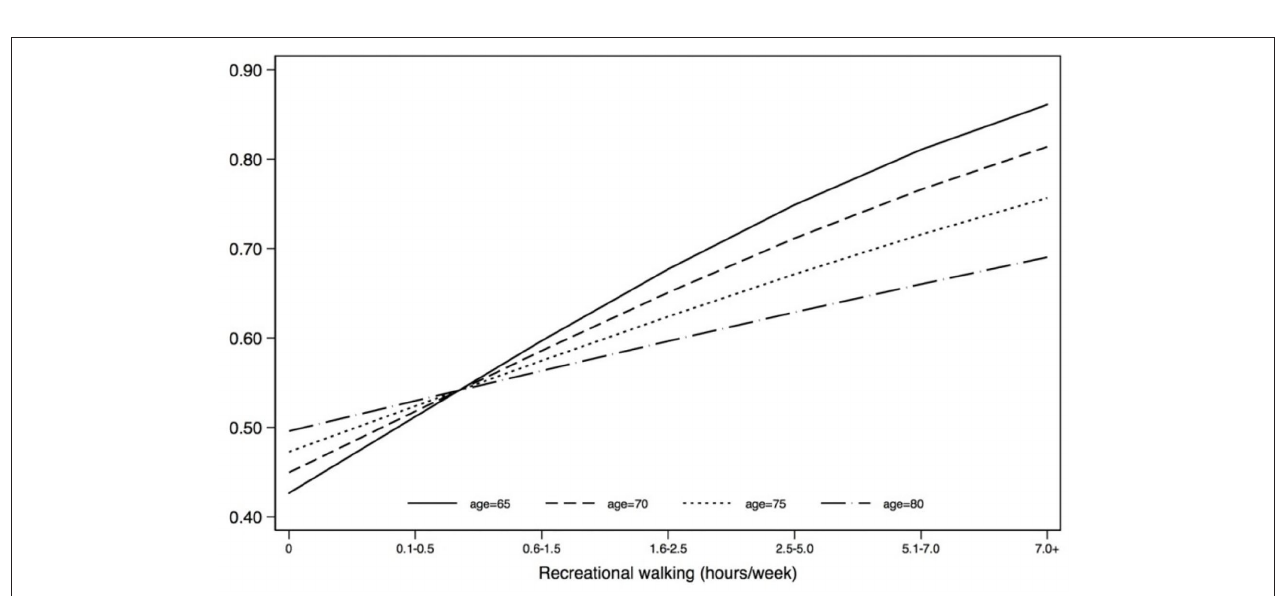
FIGURE 1 | Moderating effect of age: predicted probability of becoming a utilitarian walker by age and income (older adult model). Age (OR = 1.096, p = 0.046, 95% CI = 1.002–1.200); income (OR = 4.623, p = 0.019, 95% CI = 1.286–16.613); age*income (OR = 0.977, p = 0.008, 95% CI = 0.960–0.994).